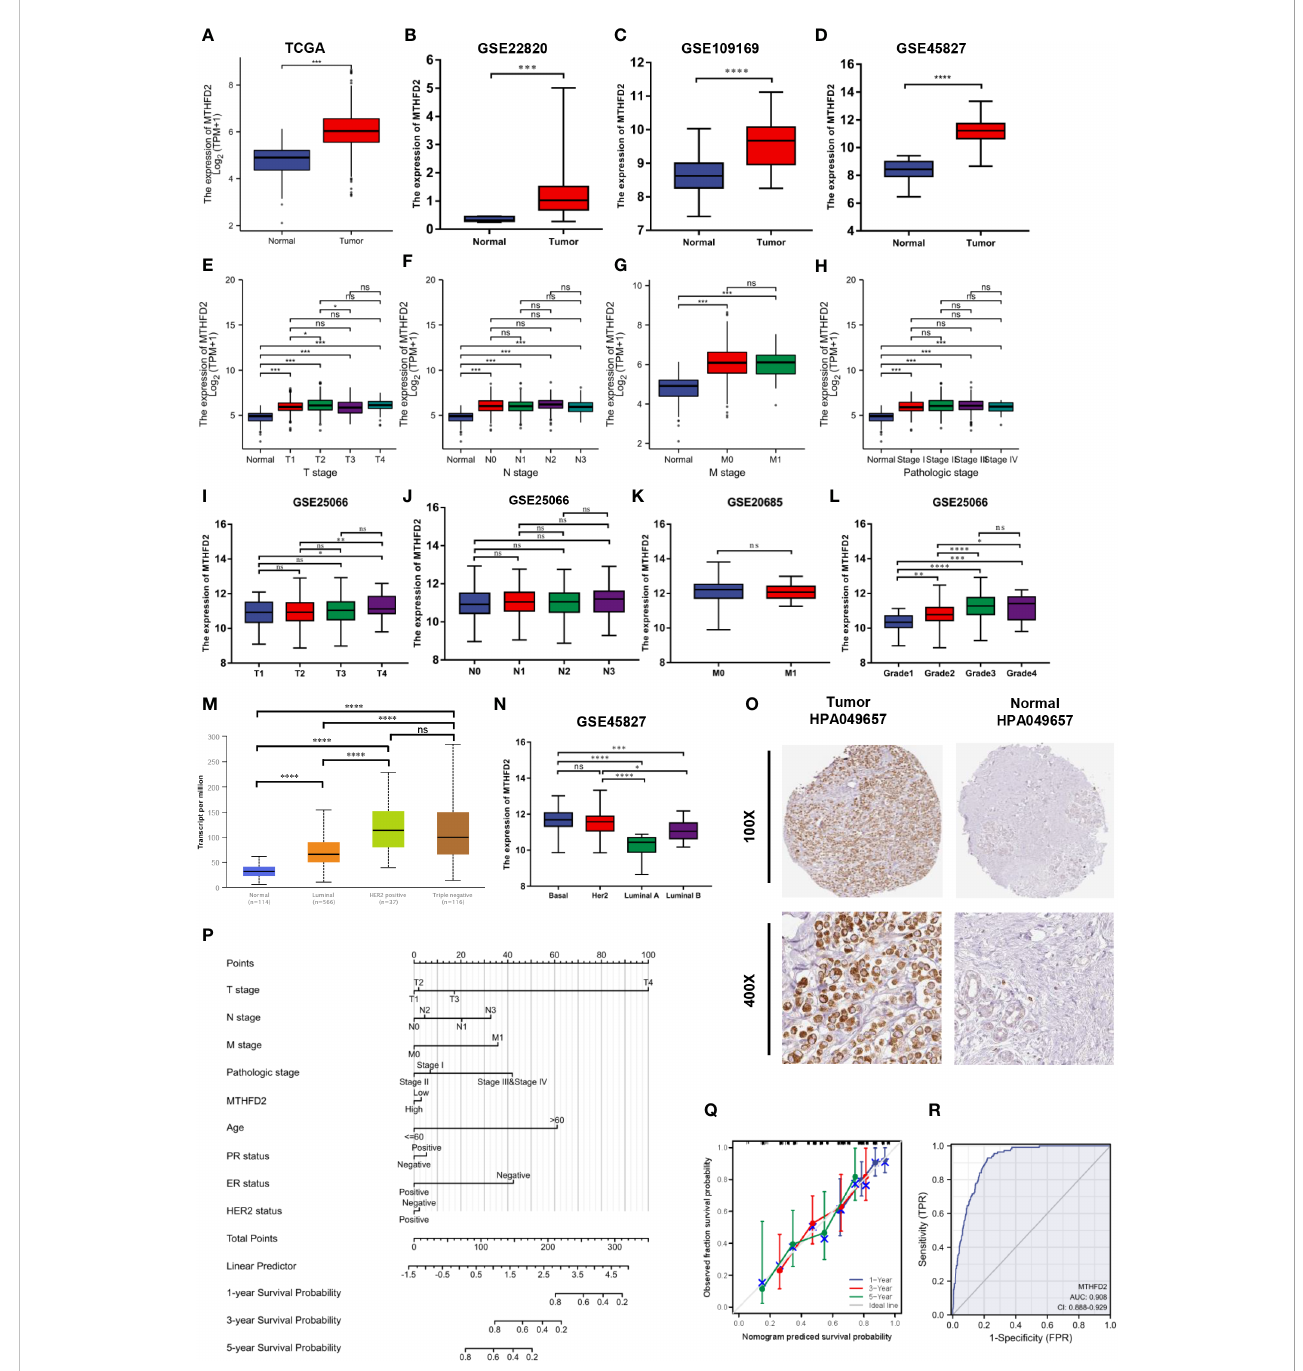
FIGURE 4 MTHFD2 expression status and clinical signi fi cance. (A – D) MTHFD2 expression level in breast cancer and normal tissues. (A) TCGA-BRCA, (B) GSE22820, (C) GSE109169, (D) GSE45827. (E – H) Relationship between MTHFD2 expression and clinical features. (E) T stage, (F) N stage, (G) M stage, (H) pathologic stage. (I – L) The relationship between MTHFD2 expression and clinical features from the GEO database. (I) T stage from GSE25066, (J) N stage from GSE25066, (K) M stage from GSE20685, (L) Grade from GSE25066. (M, N) Relationship between MTHFD2 mRNA expression and molecular subtype of breast cancer. (M) UALCAN database, (N) GSE45827. (O) MTHFD2 protein expression level in breast cancer and normal breast tissue from the HPA database (antibody, HPA049657). (P) Nomogram model integrating MTHFD2 expression and prognostic factors in breast cancer. (Q) Calibration curve of the nomogram. (R) The receiver operating characteristics curve shows an AUC value of 0.908 (con fi dence interval: 0.888-0.929) for distinguishing between normal and tumor tissue. ns: p ≥ 0.05, * p <0.05, ** p <0.01, *** p <0.001, and **** p